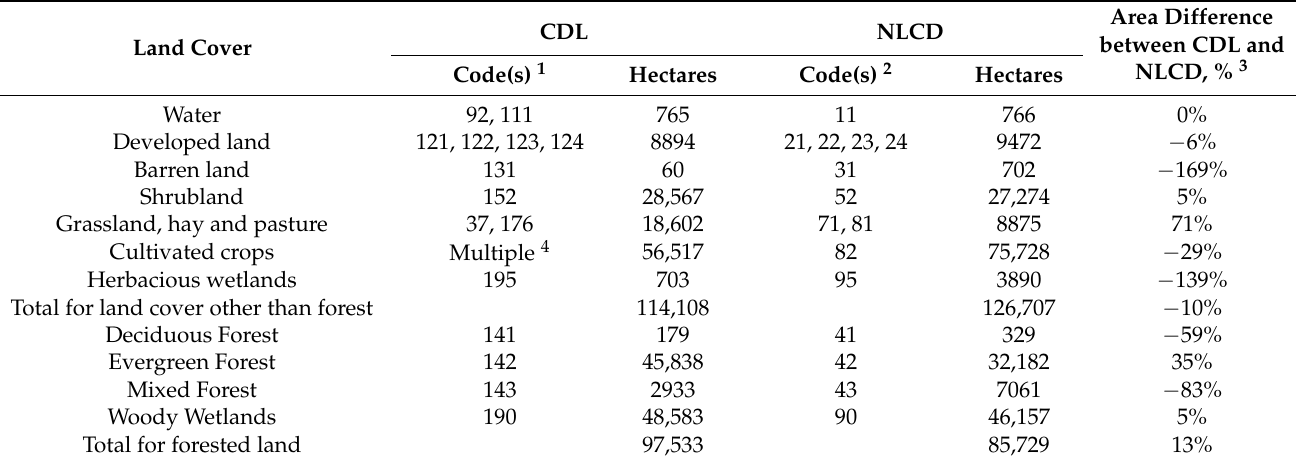
Table 1. Duplin County land cover: CDL and NLCD comparison.